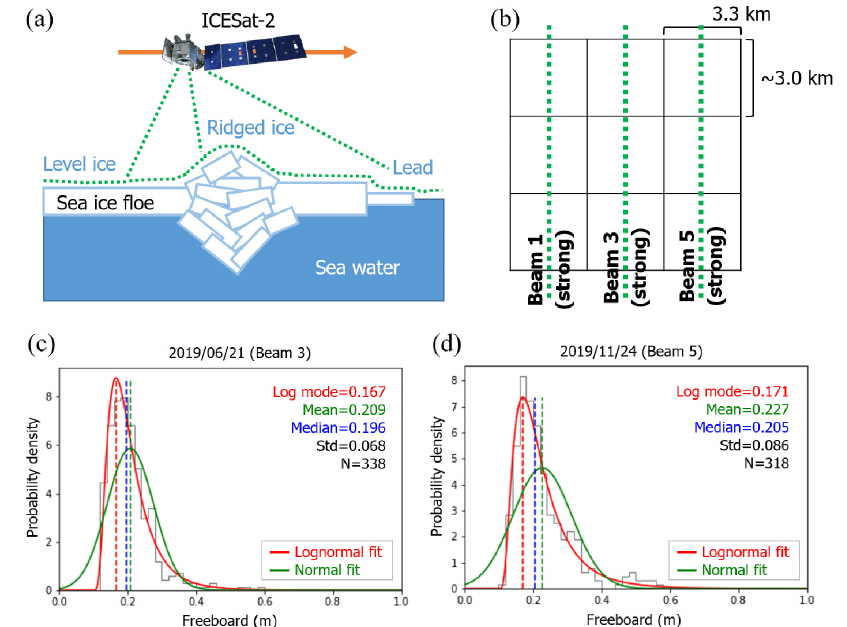
Figure 3. ( a ) Diagram of ICESat-2 photon beams over sea ice floes showing that ICESat-2 freeboard measurements include ridges and leads as well as level ice floes, ( b ) 3 km sampling of ICESat-2 data, ( c ) distribution of ATL10 freeboard for a single 3 km sample segment on 21 June 2019, and ( d ) distribution of ATL10 freeboard for a 3 km sample segment on 24 November 2019 (note that the lognormal distribution better fits the real freeboard distributions compared to the normal distribution).